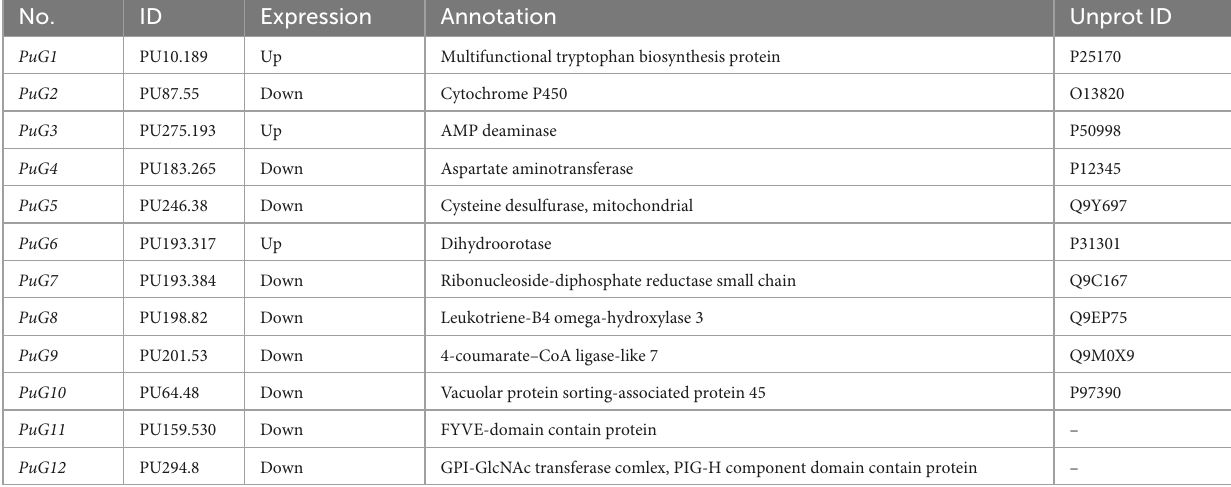
TABLE 3 PuCRZ1 target genes were differentially expressed in sclerotia and